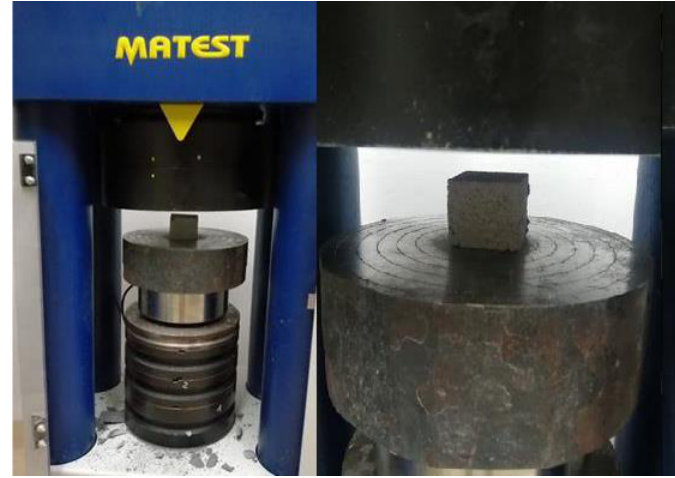
Figure 7. Way of applying a force to a sample reinforced with long fibers.